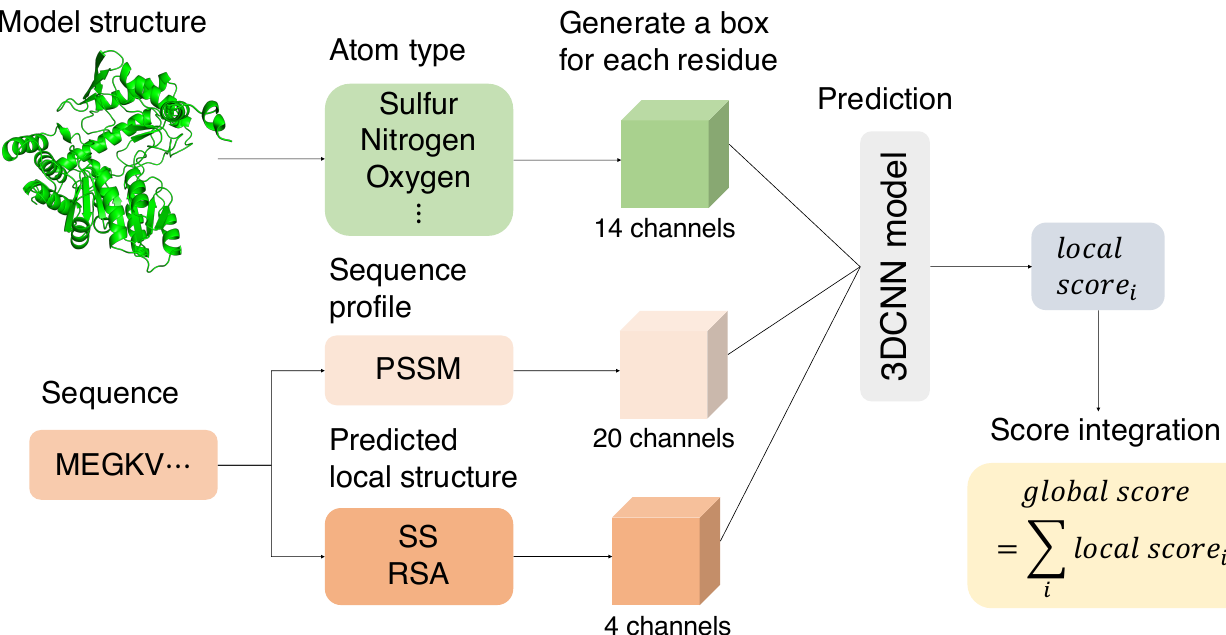
Figure 1. Overall workflow of this work. First, a bounding box is generated for each residue from the coordinate information of the model structure. Then, 14-dimensional atom-type features are obtained from the model structure. In addition, 20- dimensional sequence profile features and 4-dimensional local structure features are generated from the sequences. These features are then input to the three-dimensional convolutional neural network to predict a local score for each residue. Finally, the local scores are averaged to obtain a global score for the entire